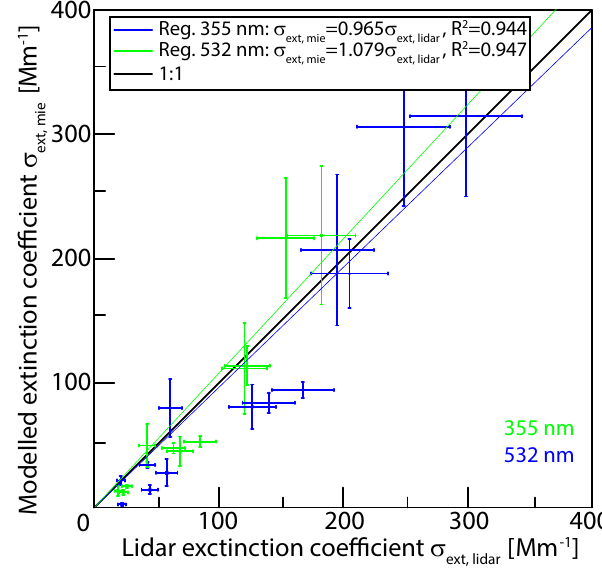
Figure 11. Correlation between the particle extinction coefficient derived from Mie modelling and hygroscopic-growth correction of in situ measurements of ACTOS with the respective ones measured with Polly XT . The dataset is based on 13 data points obtained at dif- ferent altitudes during two ACTOS flights on 14 and 17 September 2013 during HOPE-Melpitz. Adapted from Düsing et al. (2017).